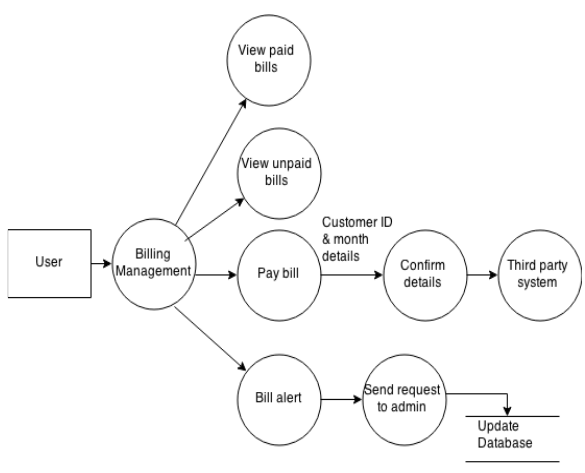
Figure 13. Billing Management System for the ISAU